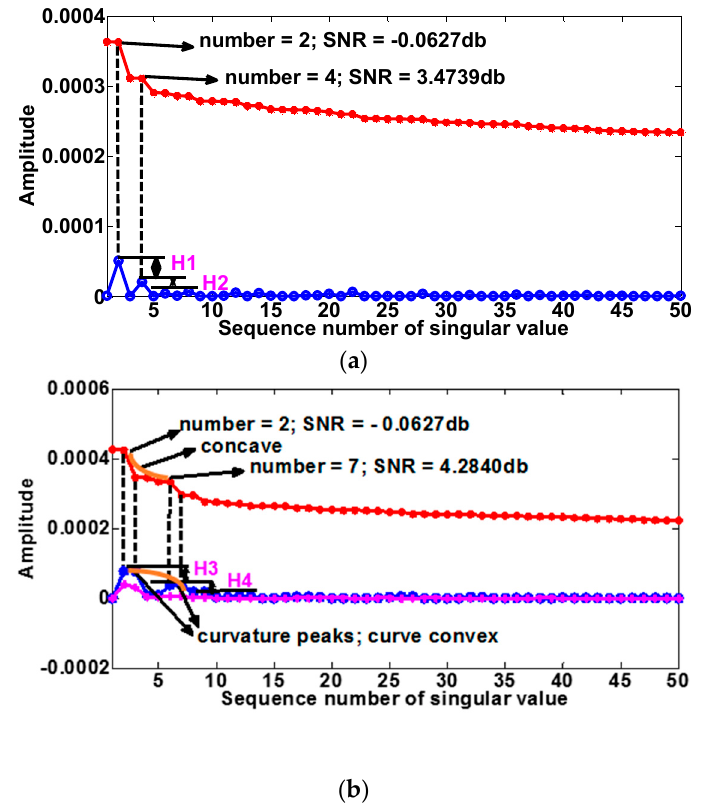
Figure 2. Comparison of different spectrum of incremental singular entropy. ( a ) Spectrum of incremental singular entropy (red) and the difference spectrum of incremental singular entropy (blue); ( b ) Spectrum of incremental singular entropy (red), curvature spectrum of incremental singular entropy (blue), and difference spectrum of adjacent curvature peaks (pink).